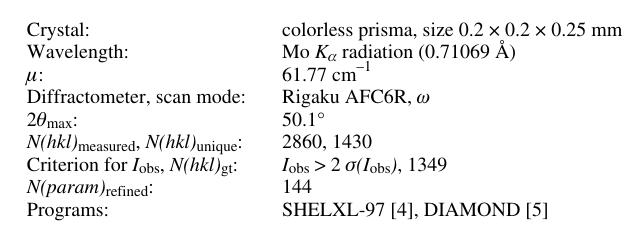
Table 1. Data collection and handling.